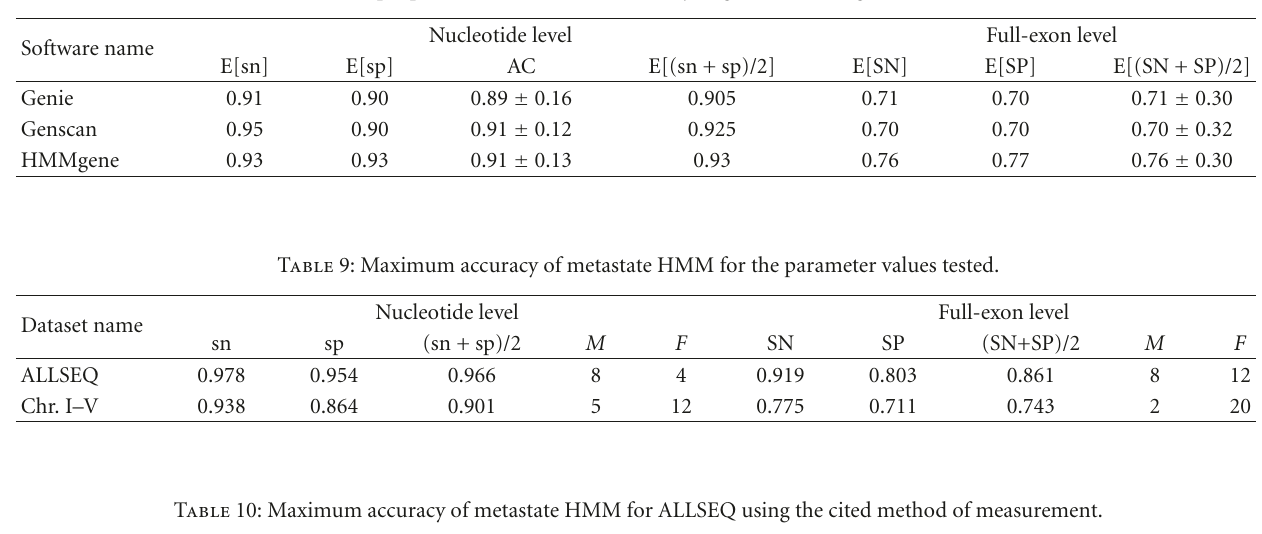
Table 8: Top 3 performers in the evaluation by Rogic et al., testing with HMR195.